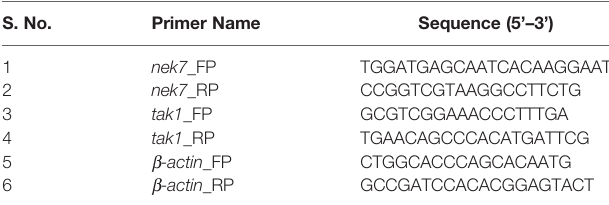
TABLE 1 | List of primer sequences used for real-time PCR